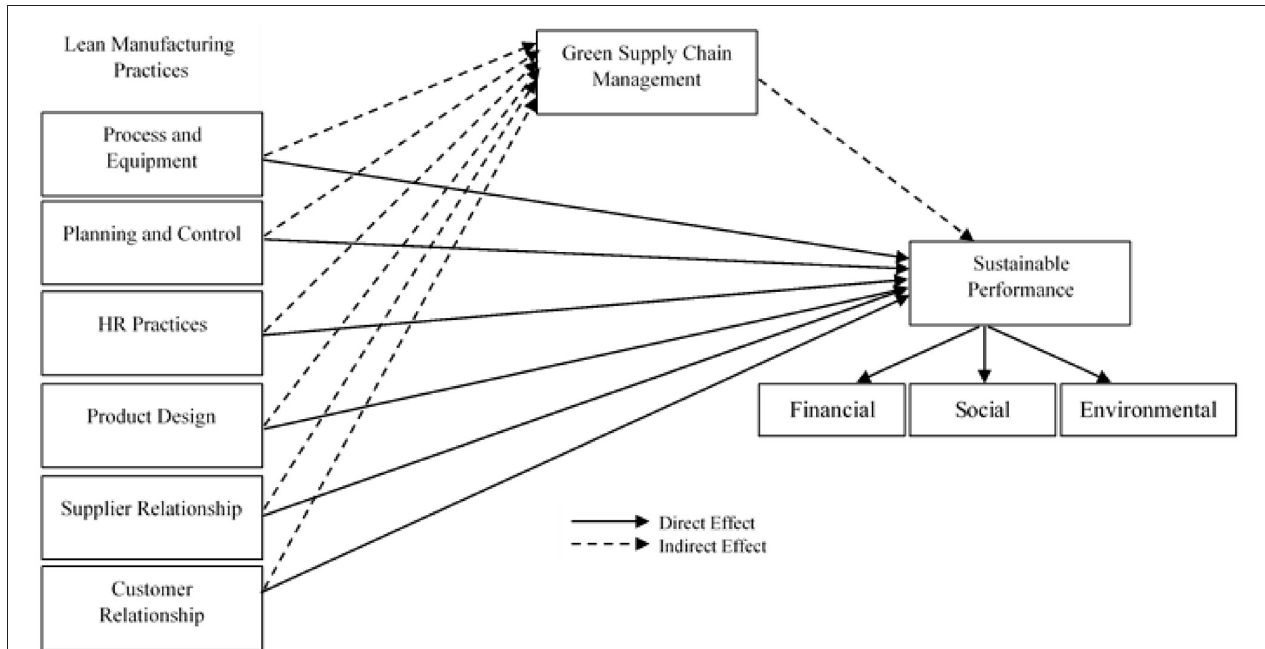
FIGURE 1 | Conceptual